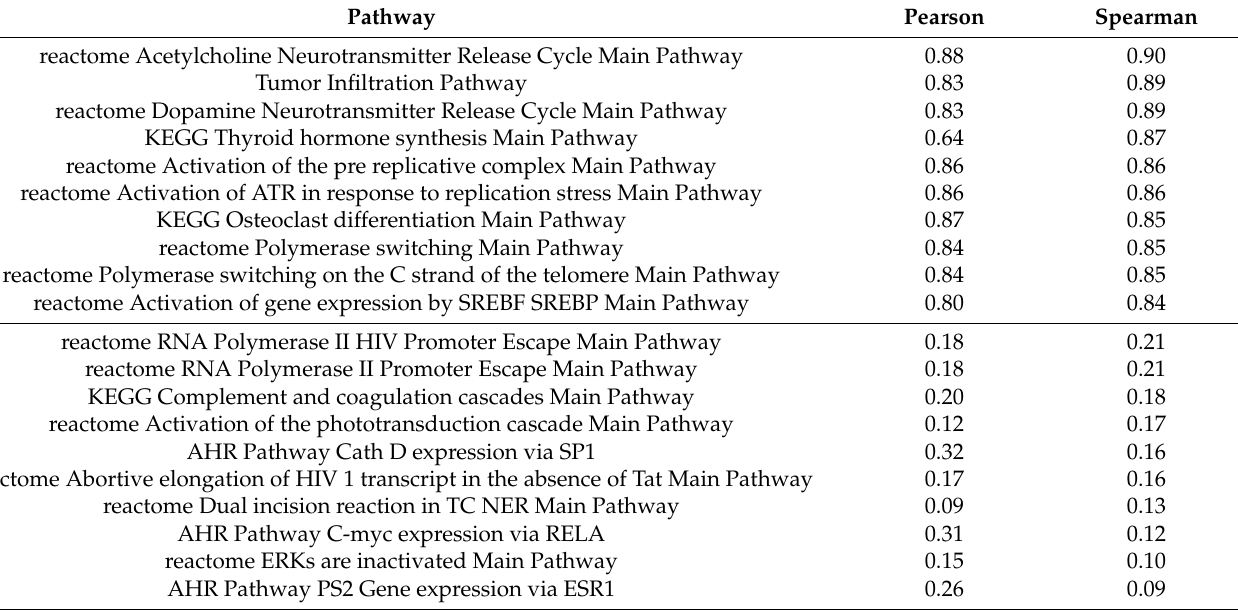
Table 4. “Top-10” of the most and the least correlated molecular pathways between RNA and protein expression data calculated for Lung Adenocarcinoma